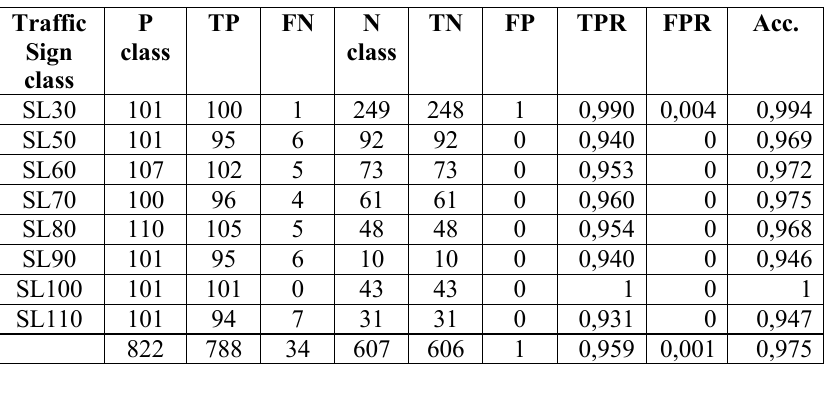
Table 2. Analysis of error rates. P class: Traffic sign, N class: Non-traffic sign, TP: True Positive, FN: False negative, TN: True Negative, FP: False Positive, TPR: True Positive Rate, FPR: False Positive Rate, Acc: